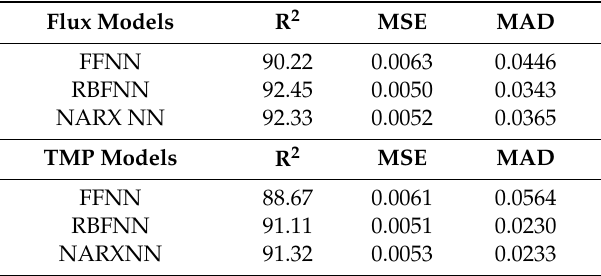
Table 3. Performance evaluation for testing